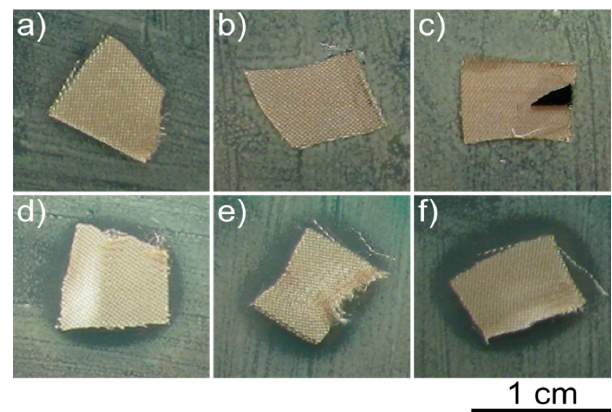
Figure 2. Testing of antimicrobial properties with the S. aureus LTSaM01 strain bacteria (disk diffusion method) of virgin Samples 1 ( a ); 2 ( b ) and 3 ( c ); as well as after 20-s plasma processing (( d – f ) respectively). The clear zone in ( d – f ) indicates areas where no bacteria multiplication is observed.